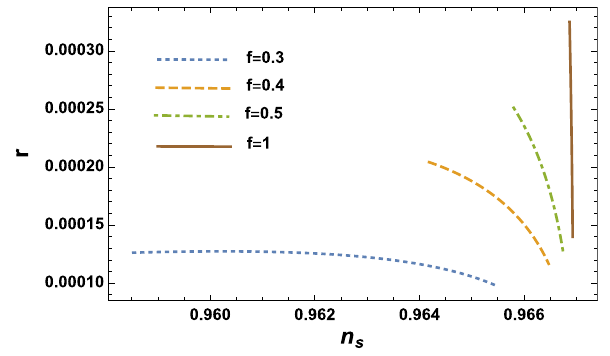
Fig. 1 n s vs r for the potential (4.27) with additional GB coupling for some values of f in the interval 0 . 3 ≤ f ≤ 1 and N = 60. The curves correspond to the narrow interval 0 . 374 < η < 0 . 37459. While n s is in the region favored by observational data, r is very small although it is within the region delimited by current observations